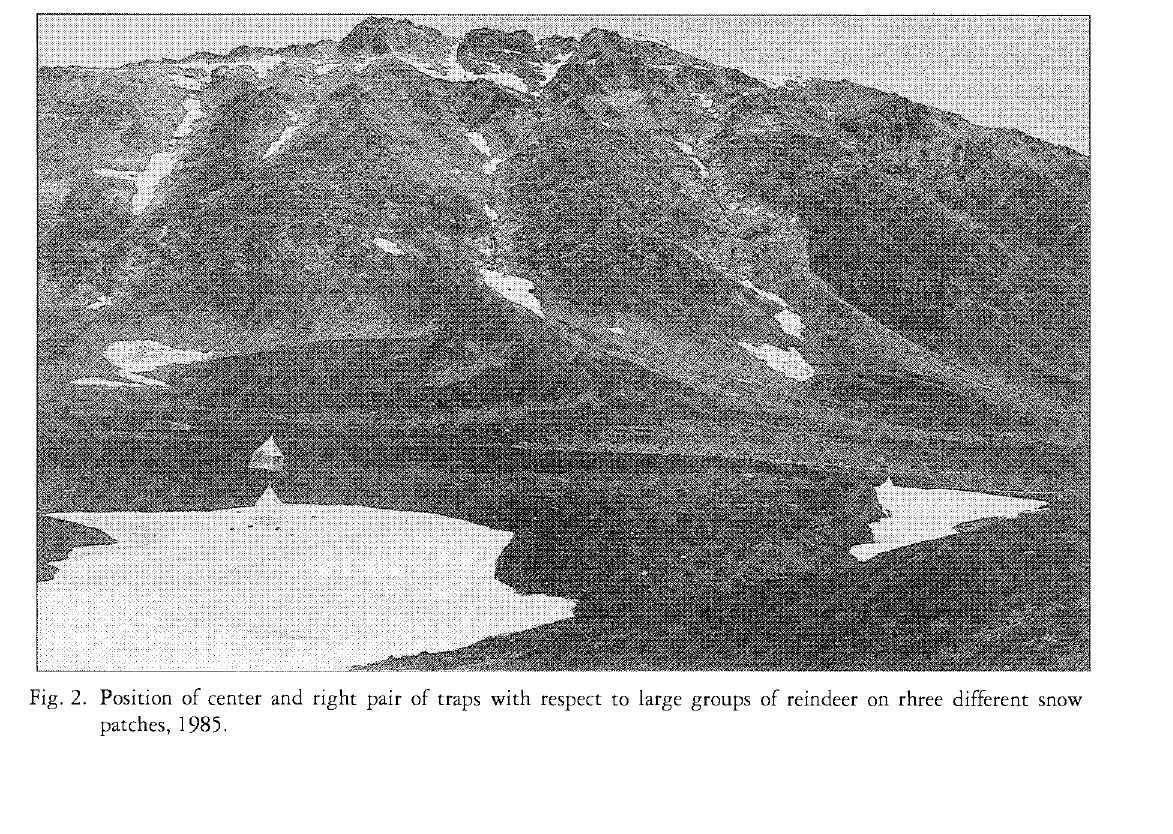
Fig. 2. Position of center and right pair of traps with respect to large groups of reindeer on rhree different snow patches, 1985.